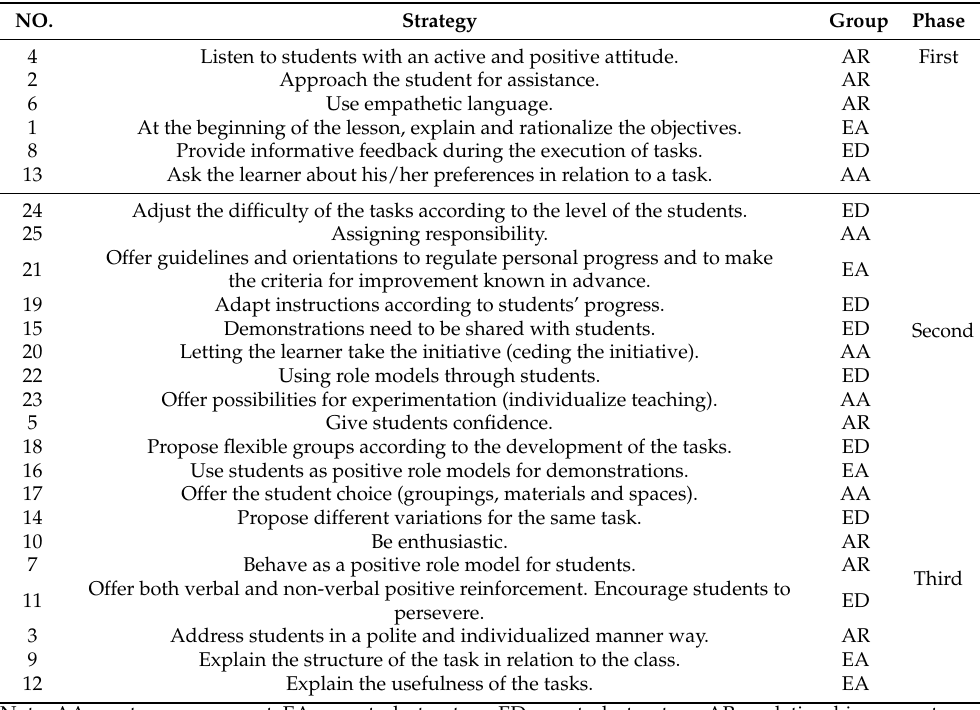
Table A7. New organizational proposal for autonomy support